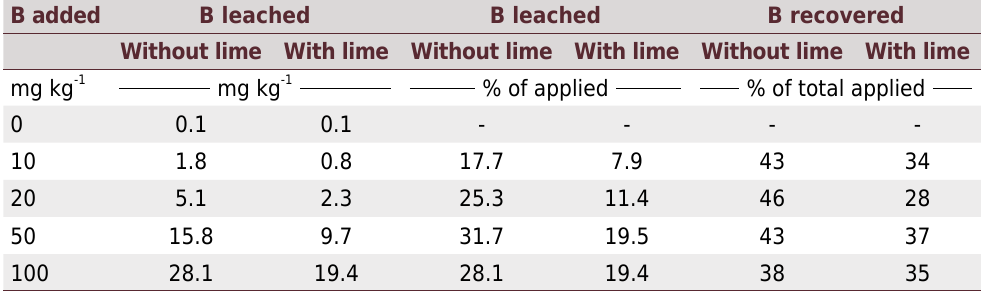
Table 1. Concentration of boron in the soil after all 15 percolations, total boron leached and total boron recovered, as affected by liming and the rate of boron addition to the soil